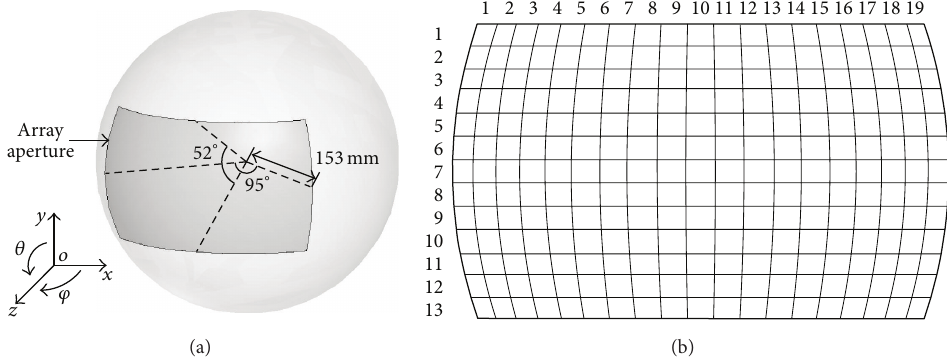
Figure 1: Sketch of the Ku-band spherical phased array antenna. (a) Geometry of the array. (b) Locations of the elements.